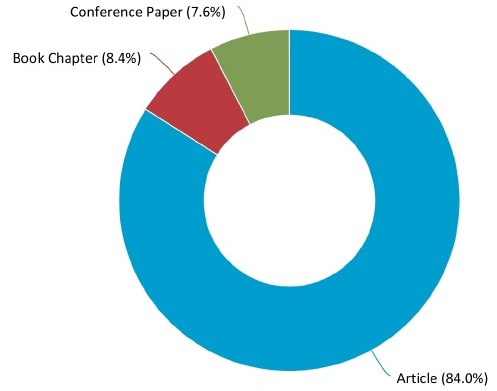
Figure 1. Documents by types (source: Scopus database)